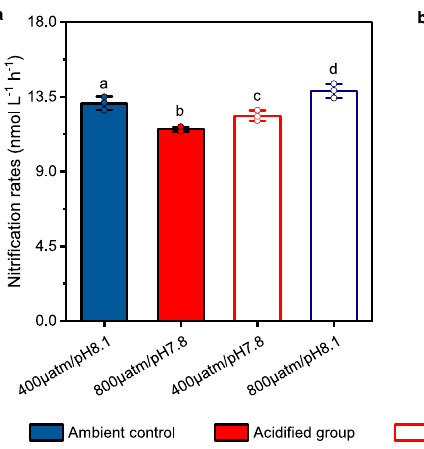
andd)abovethecolumnsindicatesigni fi cantdifferencesamongthefourscenarios ( P <0.05). Error bars represent SD ( n =3 biologically independent samples), and dots are corresponding data points of the replicates. Signi fi cant differences were determinedvia one-wayanalysis ofvariance(ANOVA).Source dataare providedas a source data fi